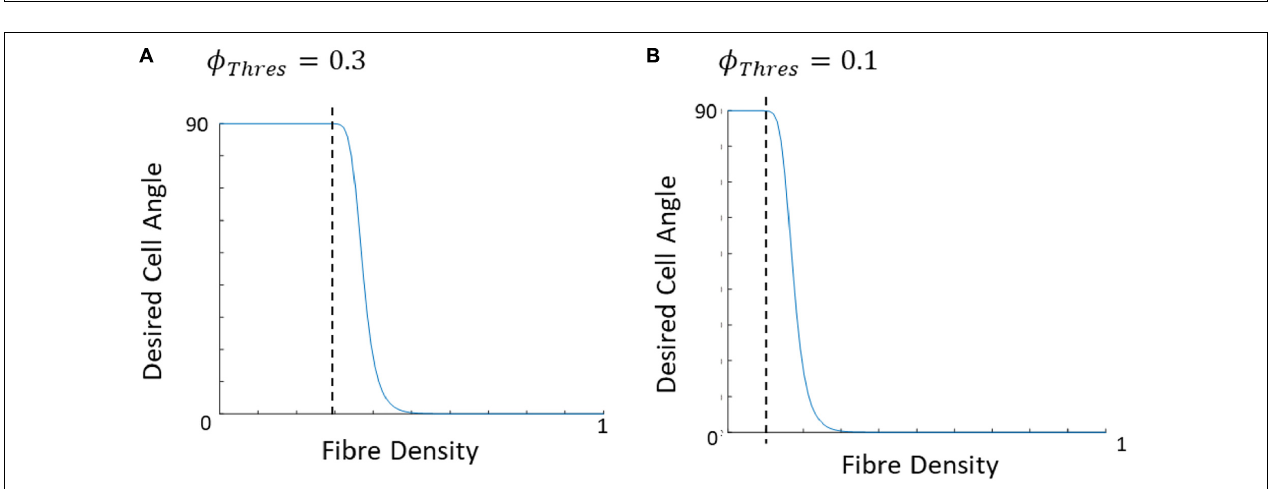
FIGURE 5 | (A) Collagenous arterial tissue, (B) an image tracking the fiber orientation in the tissue created using MatFiber (Fomovsky and Holmes, 2010), (C) a representative distribution created by the model.